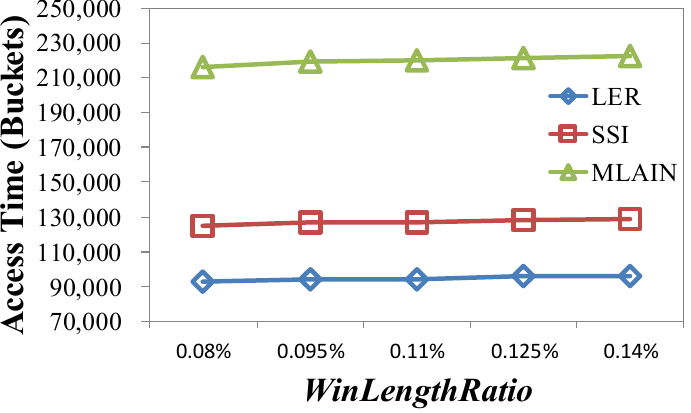
Figure 9. Average access time for changing WinLengthRatio values. Table 3. Average tuning time for changing WinLengthRatio values.